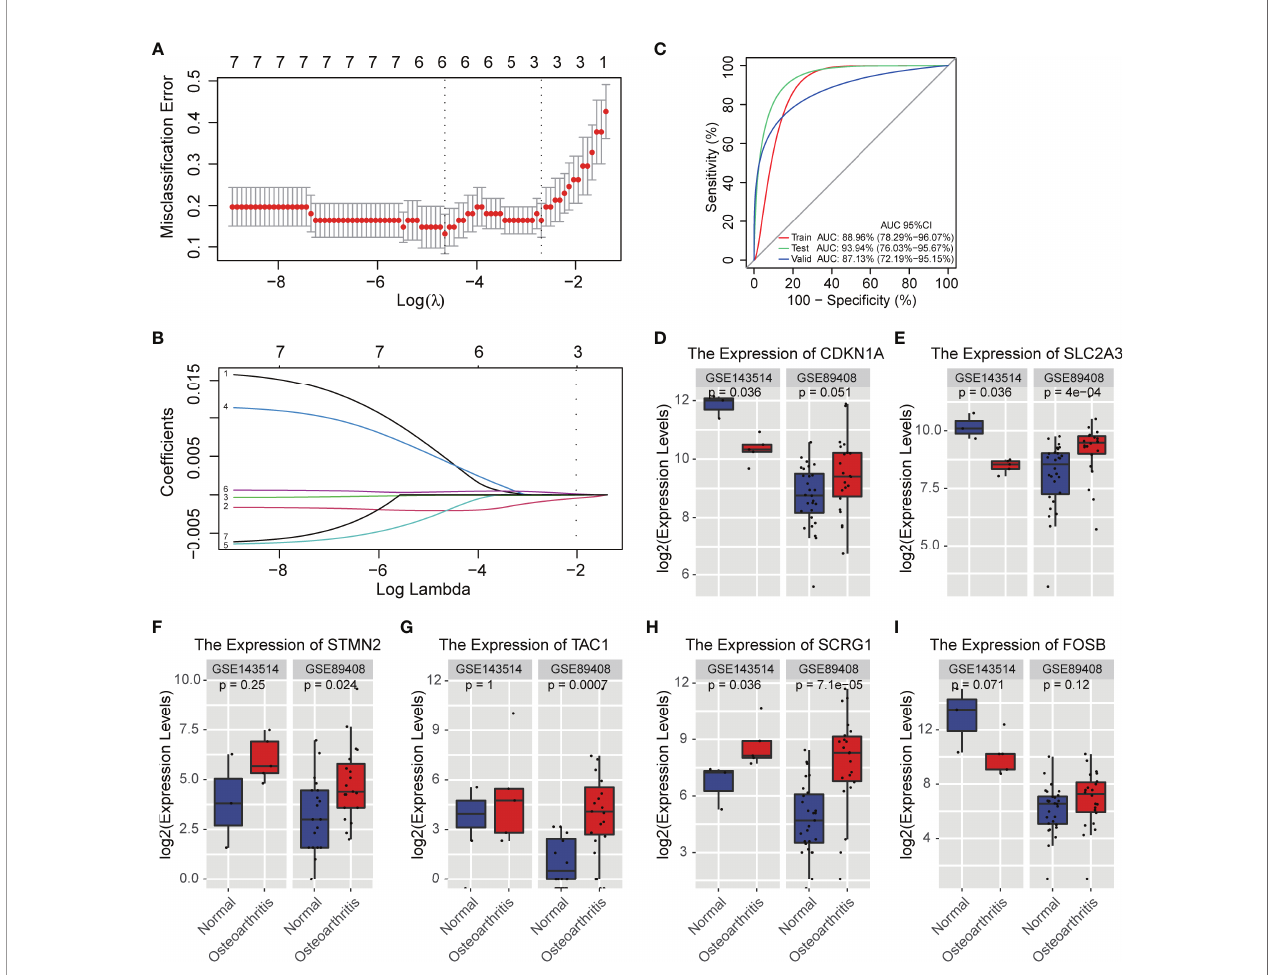
FIGURE 2 | A model for predicting OA and veri fi cation of gene differential expression. (A) CV statistical graph during the construction of the LASSO regression model, which shows that the minimum lambda at model construction is 0.00154252 (dotted line on the left). (B) the model regression coef fi cient diagram shows the change trend of the coef fi cient corresponding to each gene variable with the change of lambda value. The results showed that there were 6 prediction genes corresponding to the minimum lambda. (C) ROC curve predicts the identi fi cation effect of the above models in different datasets. The closer AUC value is to 1, the better of prediction effect on the model. The fi gure is shown that the AUC in the training set is 0.8896 and that in the test set is 0.9394, indicating that the model has good prediction accuracy. In RNA-seq validation data set, the AUC is 0.8713, which shows that the models constructed by the 6 genes can also have good accuracy in different types of data sets. (D – I) The expression levels of 6 genes affecting disease occurrence in the model are veri fi ed. The fi gure shows that 6 genes are also signi fi cantly differentially expressed in the RNA-SEQ data